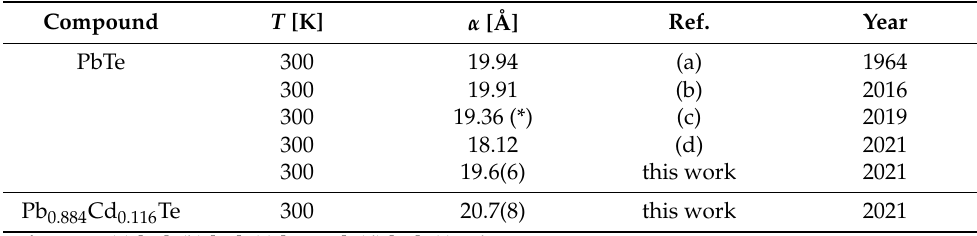
Table 8. Present and selected literature values of the experimental thermal expansion coefficient, α , at